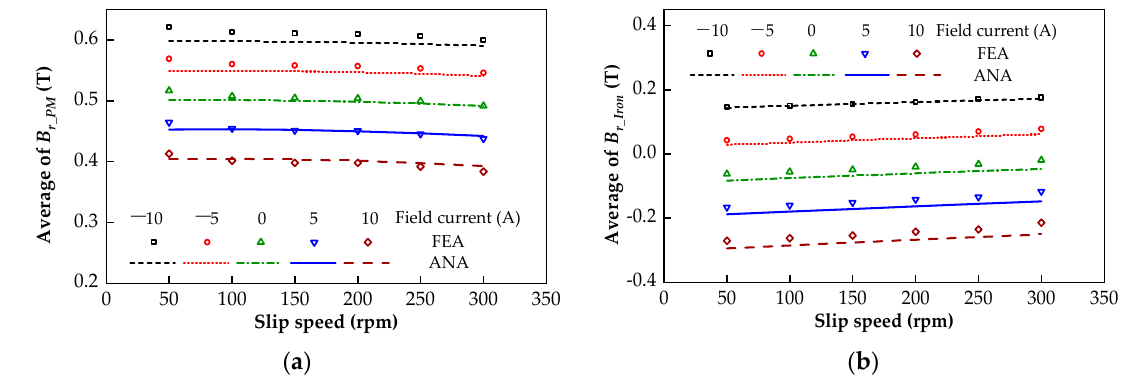
Figure 7. The average values of flux densities under different field currents. ( a ) The average values of B r_PM . ( b ) The average values of B r_Iron .